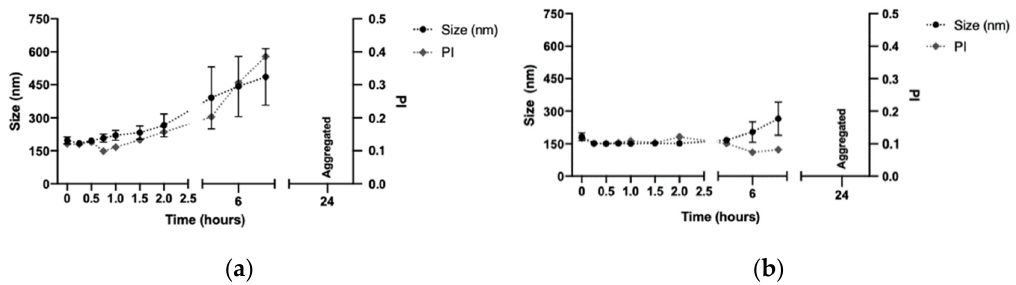
Figure 4. Stability of dextran nanocapsules (DX NC*) with or without imiquimod in their core. Con- ditions: PBS (pH 7,2), 37 °C. ( a ) Size and polydispersity index of DX NC*. ( b ) Size and polydispersity index of DX NC-imq*. Imq: imiquimod. IP: polydispersity index. * Formulation elaborated applying high manual pressure. (Mean ± SD, n = 3).